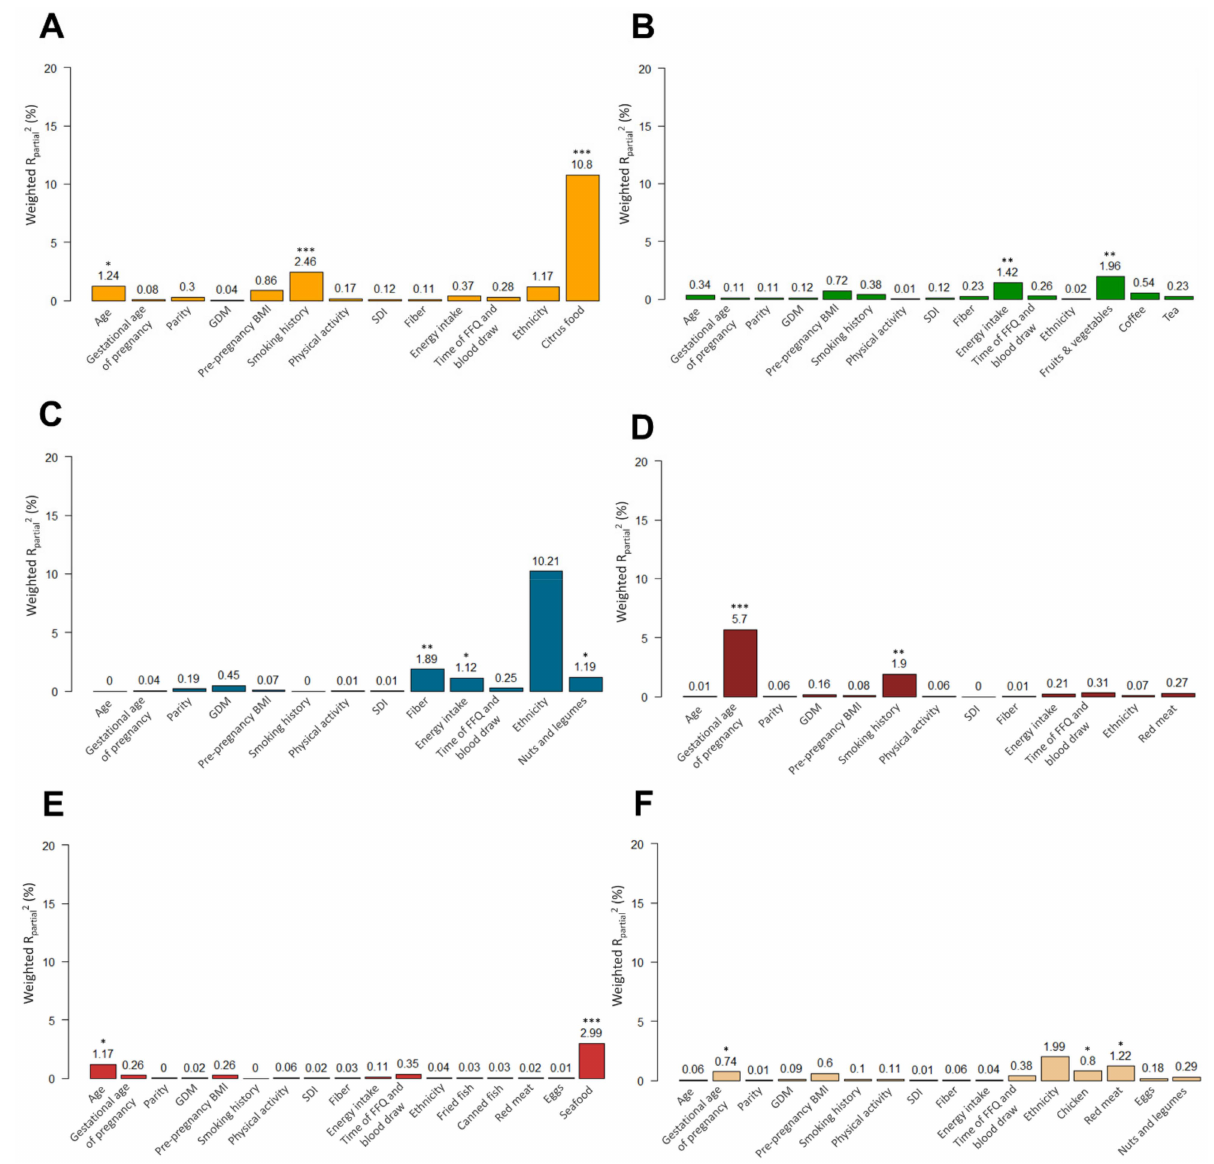
Figure 1. Weighted R partial2 for each factor showing the percentage of explained variability in: ( A ) Proline betaine, ( B ) Hippuric acid, ( C ) Tryptophan betaine, ( D ) Carnitine, ( E ) trimethylamine N -oxide (TMAO), and ( F ) 3-methylhistidine. Statistical significance was based on hierarchical linear models. * p ≤ 0.05, ** p ≤ 0.01, *** p ≤ 0.001. Intraclass correlation suggested a cluster effect by ethnicity (level 2 factor) for proline betaine (ICC = 3.9%), tryptophan betaine (ICC = 46.0%), TMAO (ICC = 7.0%), and 3-methylhistidine (ICC = 25.6%) and did not suggest a cluster effect by ethnicity for hippuric acid (ICC = 0.0%) and carnitine (ICC =